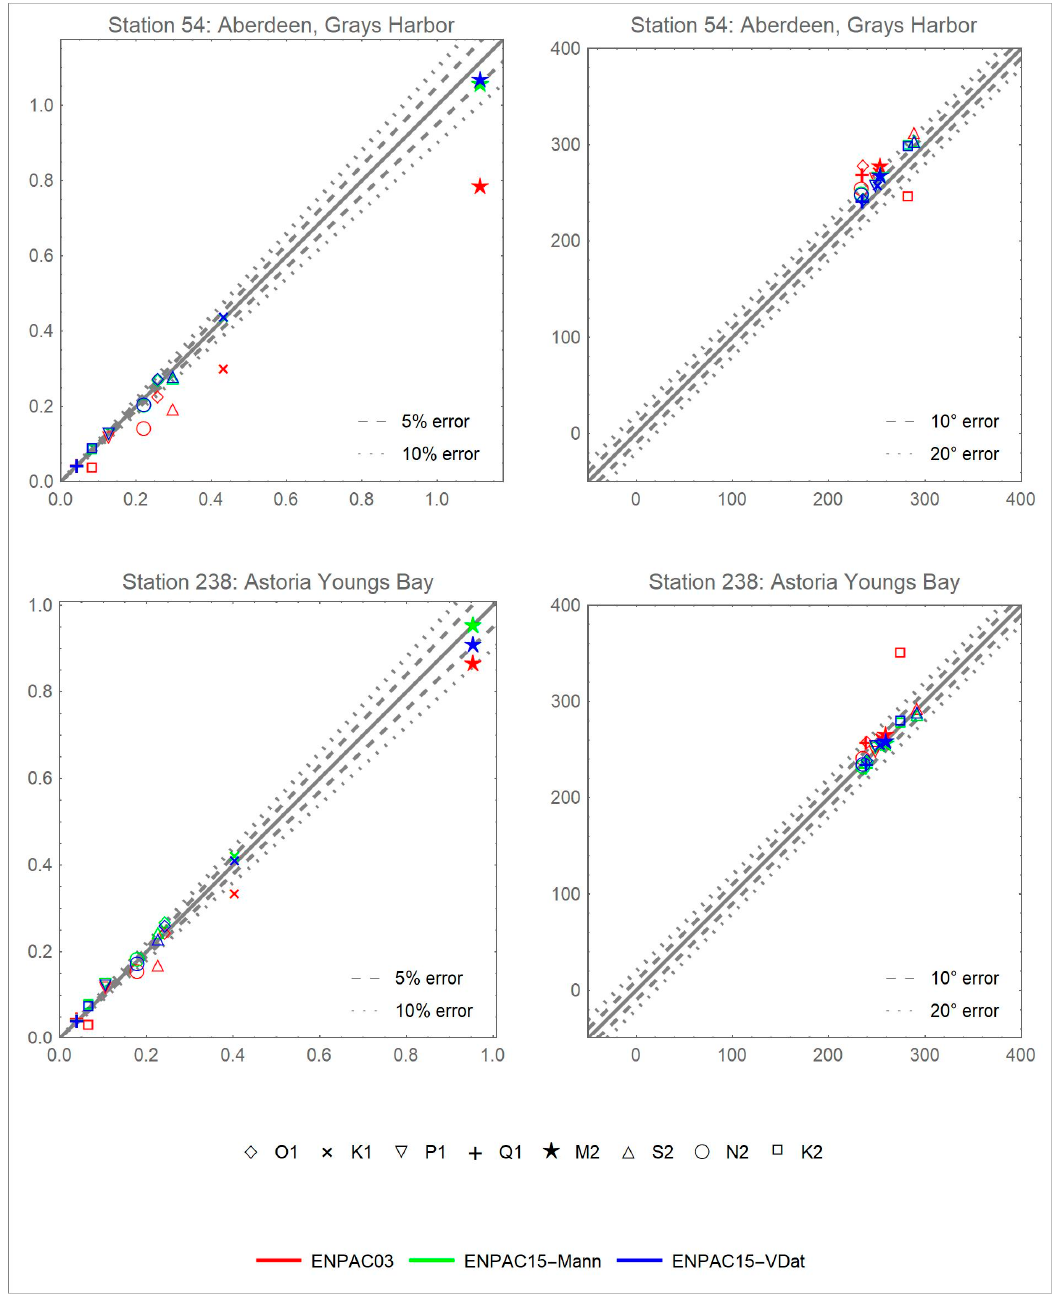
Figure A9. Scatterplots of errors for two Oregon/Washington stations, locations shown in Figure A3.